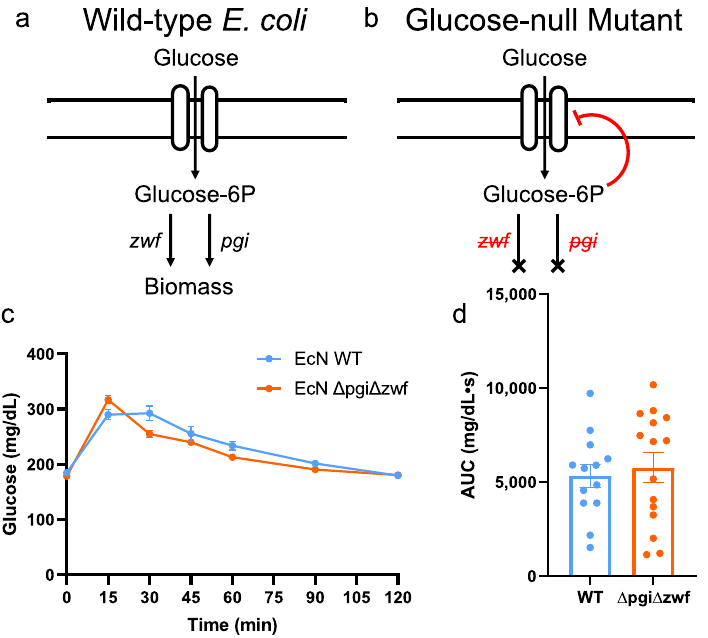
Figure 2. A glucose-null mutant of E. coli Nissle 1917 has no impact on blood glucose AUC compared to wild type. ( a ) Simplified view of glucose metabolism in E. coli . Hexokinase transports glucose from extracellular space into the cytoplasm and phosphorylates, generating glucose-6-phosphate. Glucose-6P is processed via zwf into the pentose phosphate pathway or via pgi into glycolysis. Knocking out both genes causes buildup of glucose-6P, eliminating further glucose uptake via feedback inhibition. ( b ) OGTT showing blood glucose over time following oral glucose gavage (n = 14). Points represent mean and bars represent SEM ( c ) AUC of the OGTT (n = 14). Points represent individual mice and bars represent mean and SEM. p values calculated in ( b ) using repeated measures ANOVA with Tukey’s post-hoc test, and in c using student’s T-test.